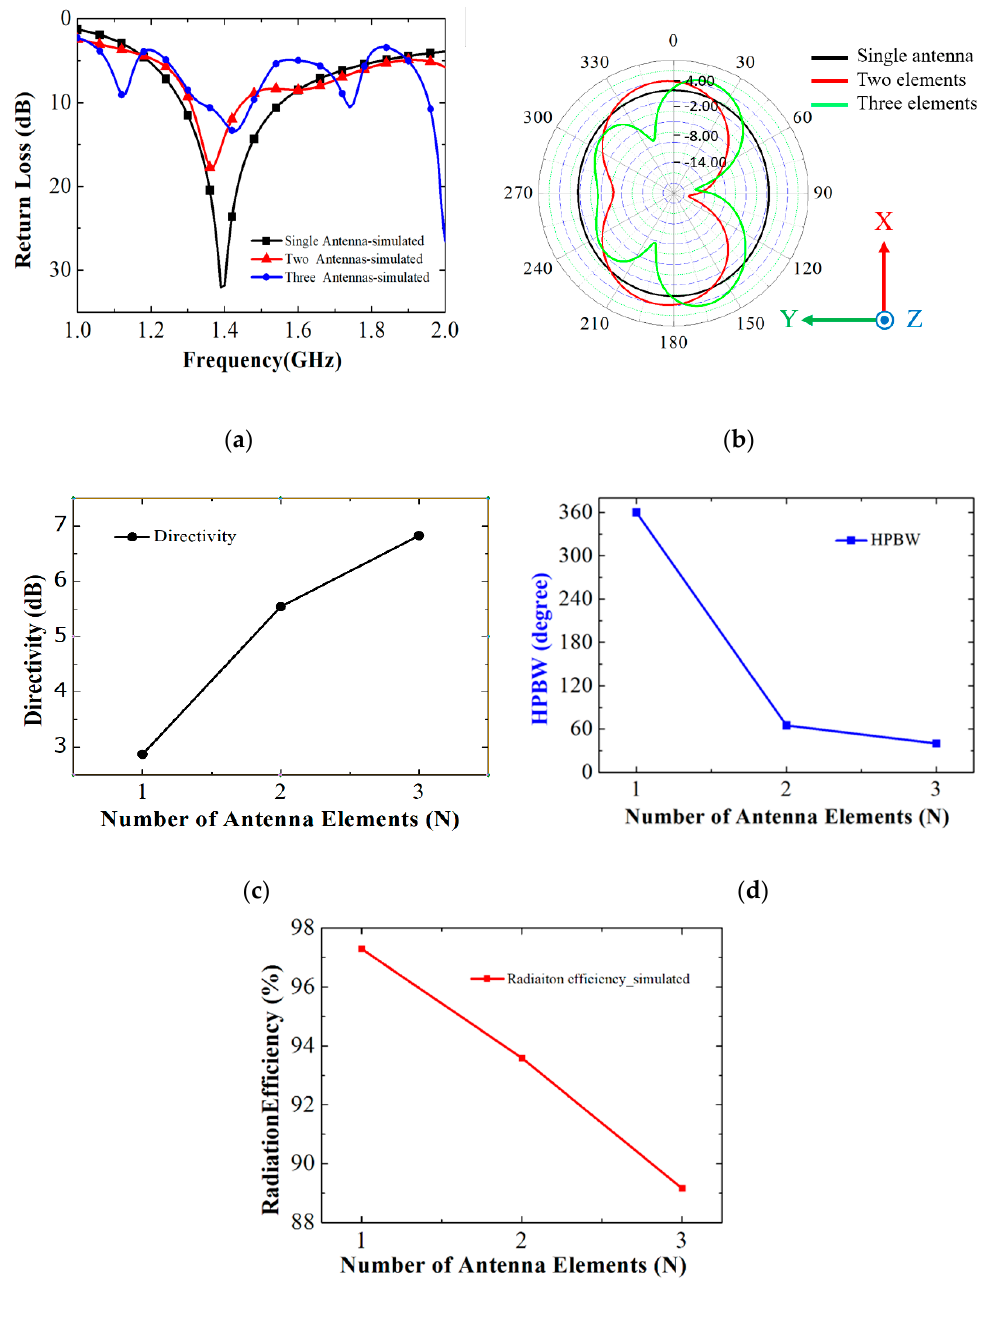
Figure 4. Simulated ( a ) return loss, ( b ) 2D radiation pattern on XY plane, ( c ) directivity, ( d ) half-power beam width (HPBW), and ( e ) radiation efficiency for different numbers of antenna elements of the antenna array.